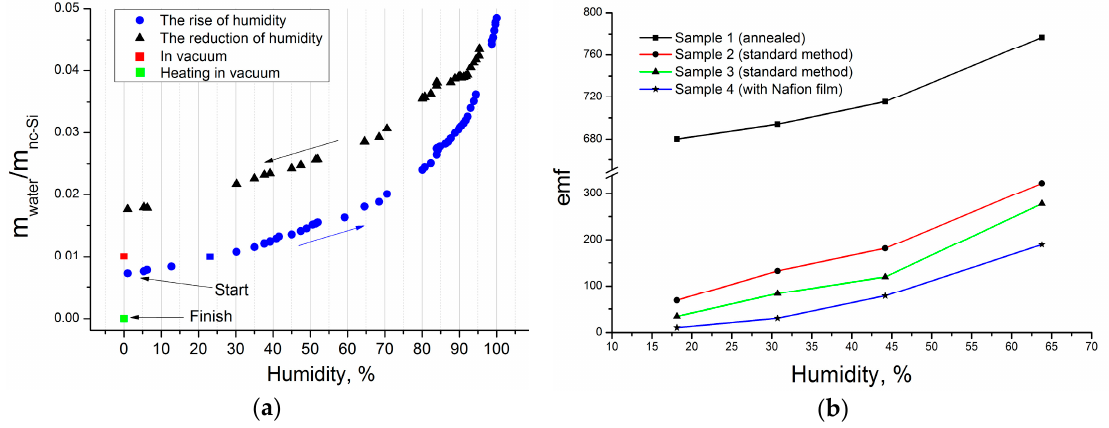
Figure 5. ( a ) Relative mass of water absorbed by nc-Si film during the humidity experiment. ( b ) Dependences of the emf of different samples on relative humidity of surrounding atmosphere at T = 300 K. Sample 1 was annealed in vacuum before; Sample 2 and Sample 3 are different samples on the same substrate. Sample 4 contains Nafion film.